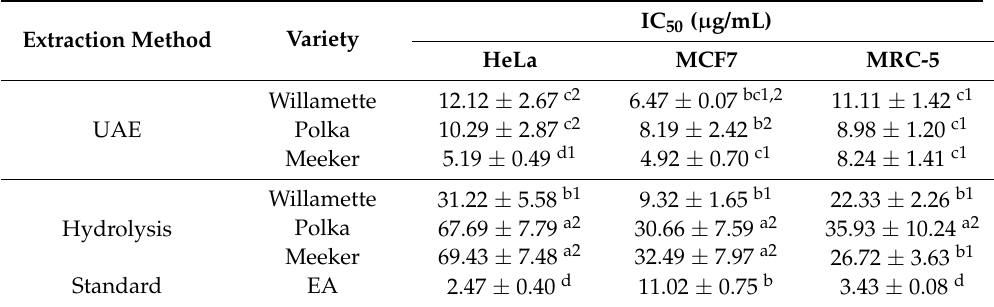
Table 7. Antiproliferative activity of the polyphenolic extracts of all examined raspberry varieties, obtained using UAE under optimal conditions and after